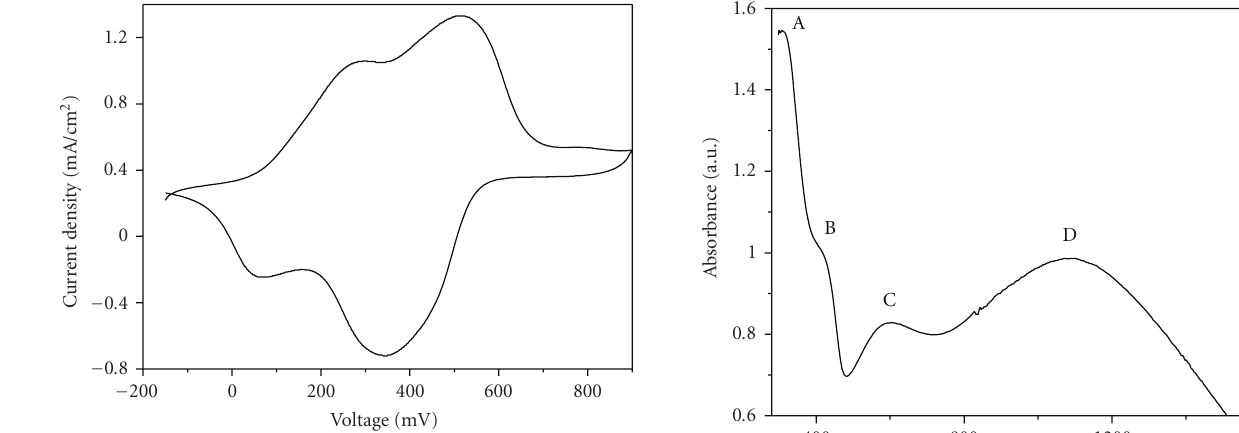
Figure 1: Cyclic voltammograms recorded during the synthesis of PANI-co-POT films.